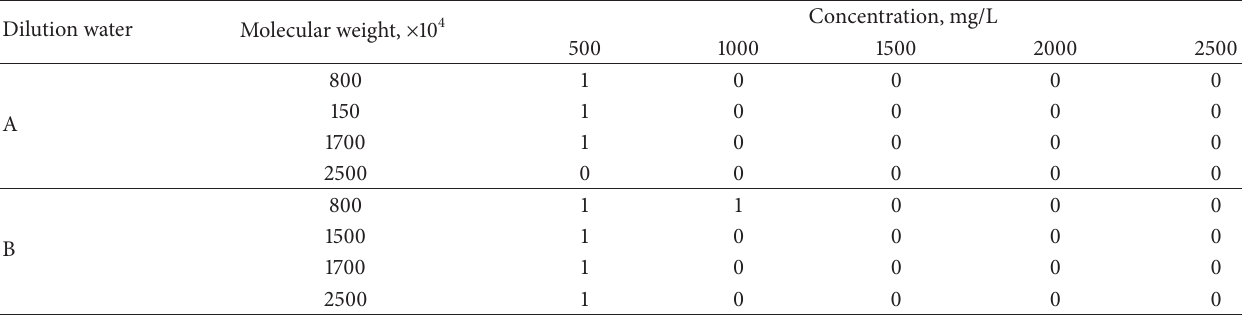
Table 6: The matching relationship plate for reservoirs with permeability 337 × 10 −3 𝜇 m 2 .